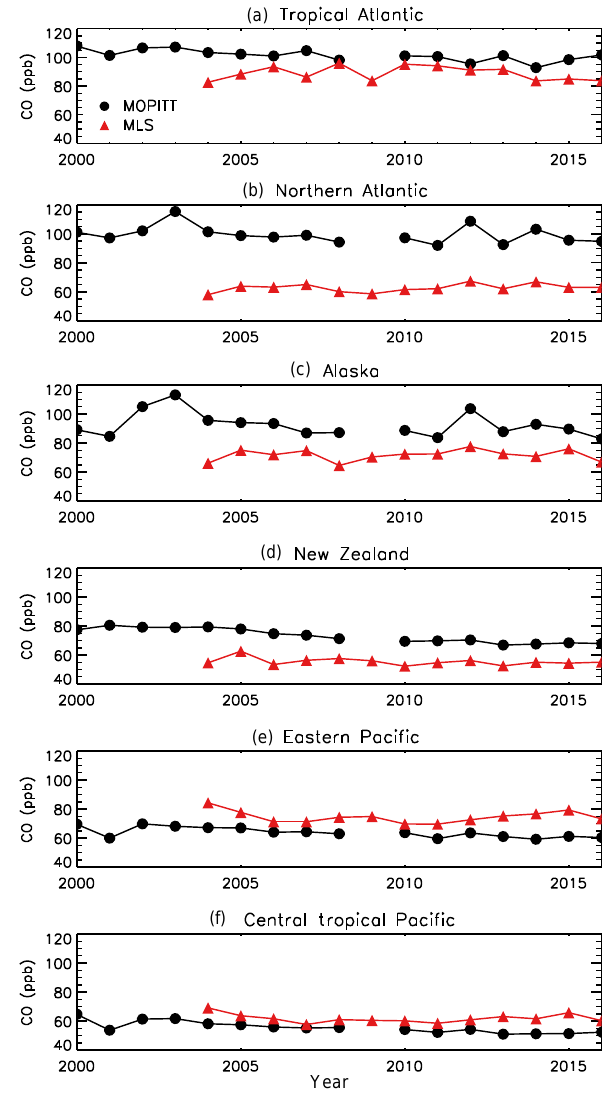
Figure 10. Time series of August MOPITT CO at the 700hPa level (black circles) and MLS CO (red triangles) at the 215hPa level for the six regions shown in black in Fig. 8.